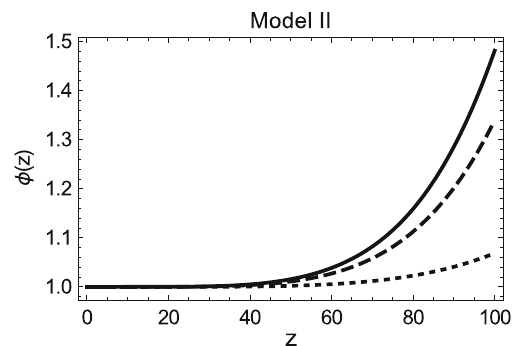
Fig. 3 BD scalar field for model I I as a function of redshift using different values of n . In the figure, n = − 0 . 01: black, n = − 0 . 2: black, dashed, n = − 0 . 5: black,